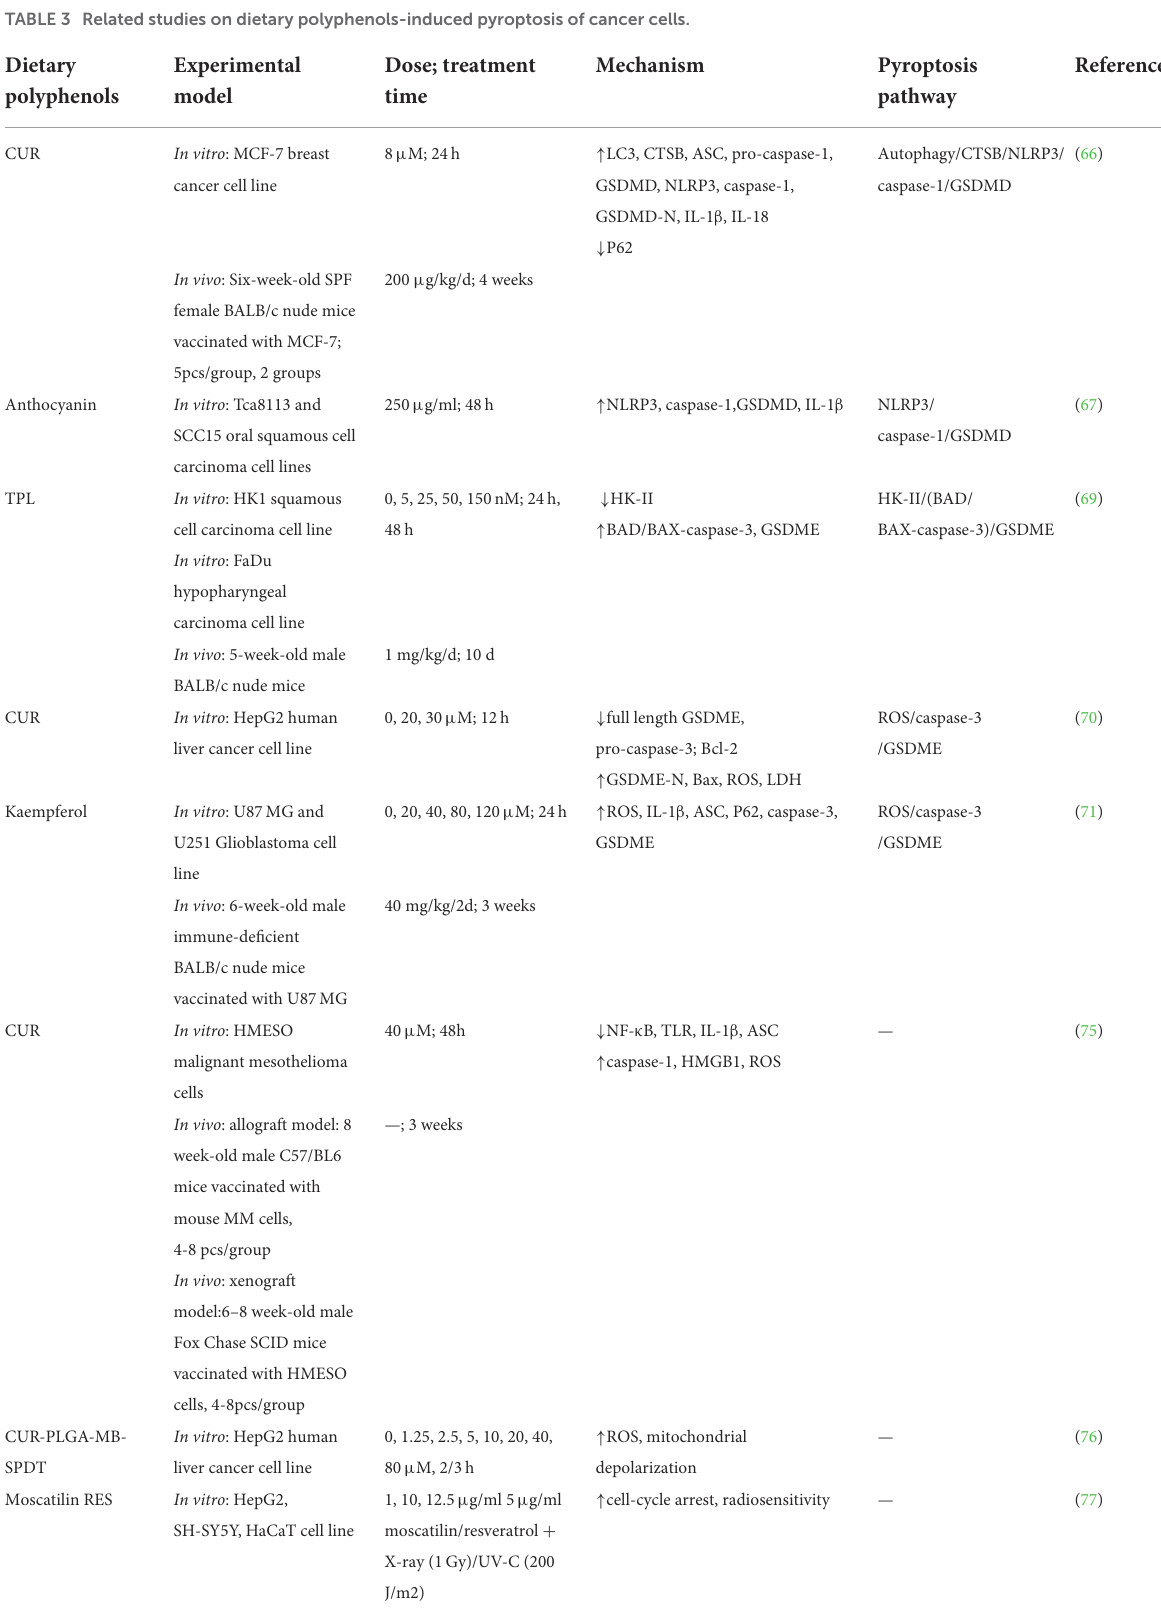
TABLE 3 Related studies on dietary polyphenols-induced pyroptosis of cancer cells. Dietary Experimental polyphenols model